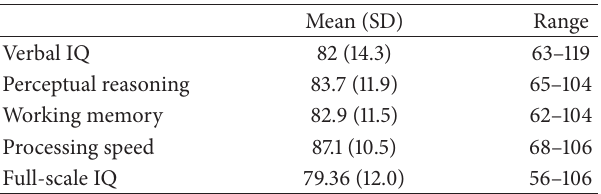
Table 1: Average scores in the WISC in our sample of children with RAD ( 𝑛 = 14